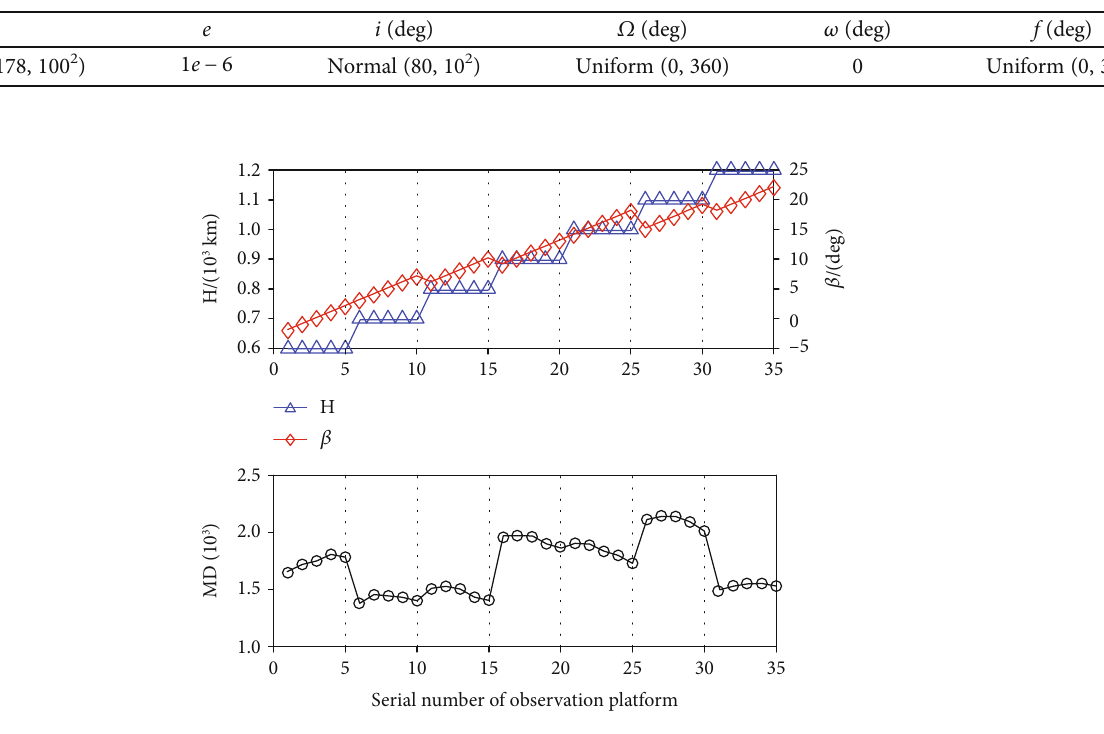
Table 4: The initial distribution of the debris population (100 objects).